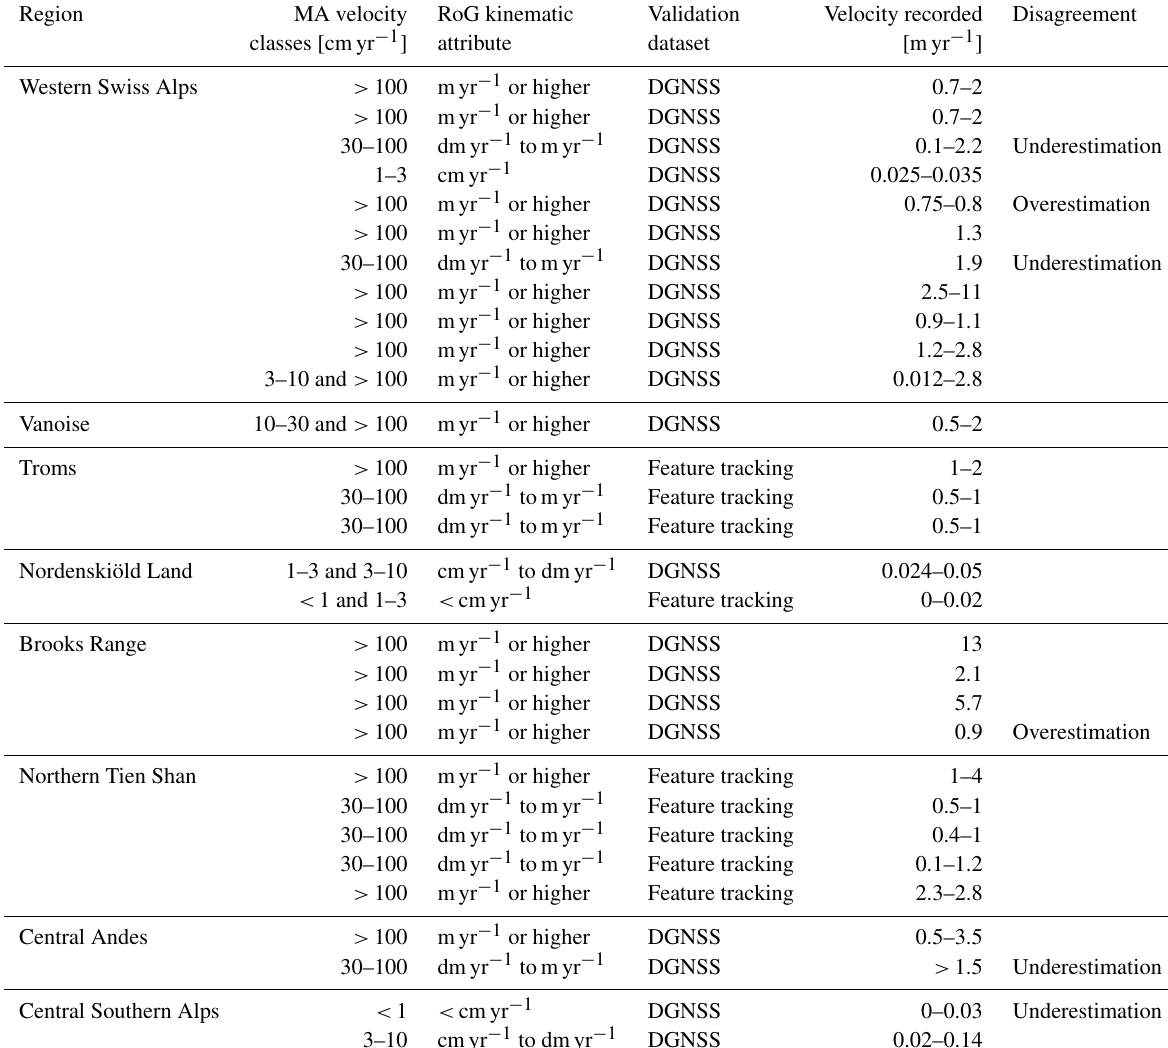
Table 3. Validation conducted between the detected kinematic information (i.e. MA velocity classes and RoG kinematic attributes) and the independent datasets available for some